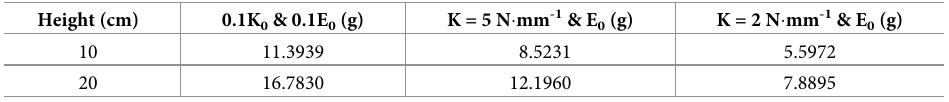
Table 4. Cushioning performance of the bio-inspired foot. Peak accelerations of the bio-inspired foot with specific elastic modulus and spring stiffness at different heights on loose